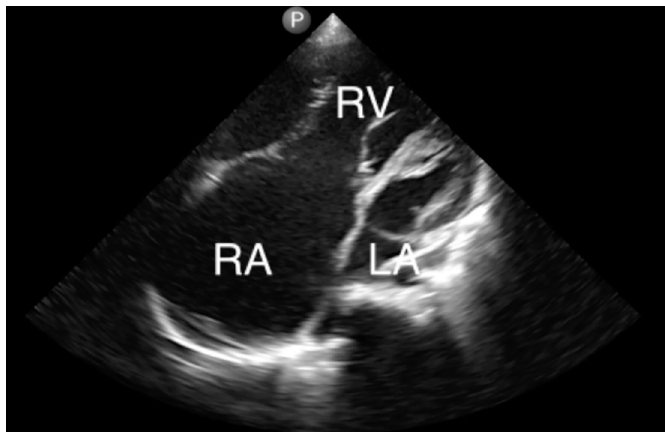
Image 3. Point-of-care ultrasound apical 4-chamber view of patient with Ebstein’s anomaly demonstrating the dilated right heart chambers. The left ventricle is demonstrated by the arrow. RV, right ventricle; RA, right atrium; LA, left atrium.